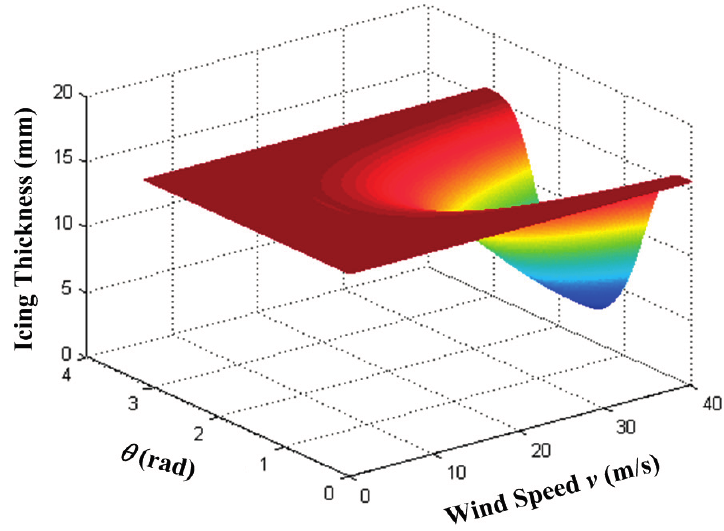
Figure 11. Icing thickness as functions of the wind speed v , and the angle between wind direction and determinand line θ